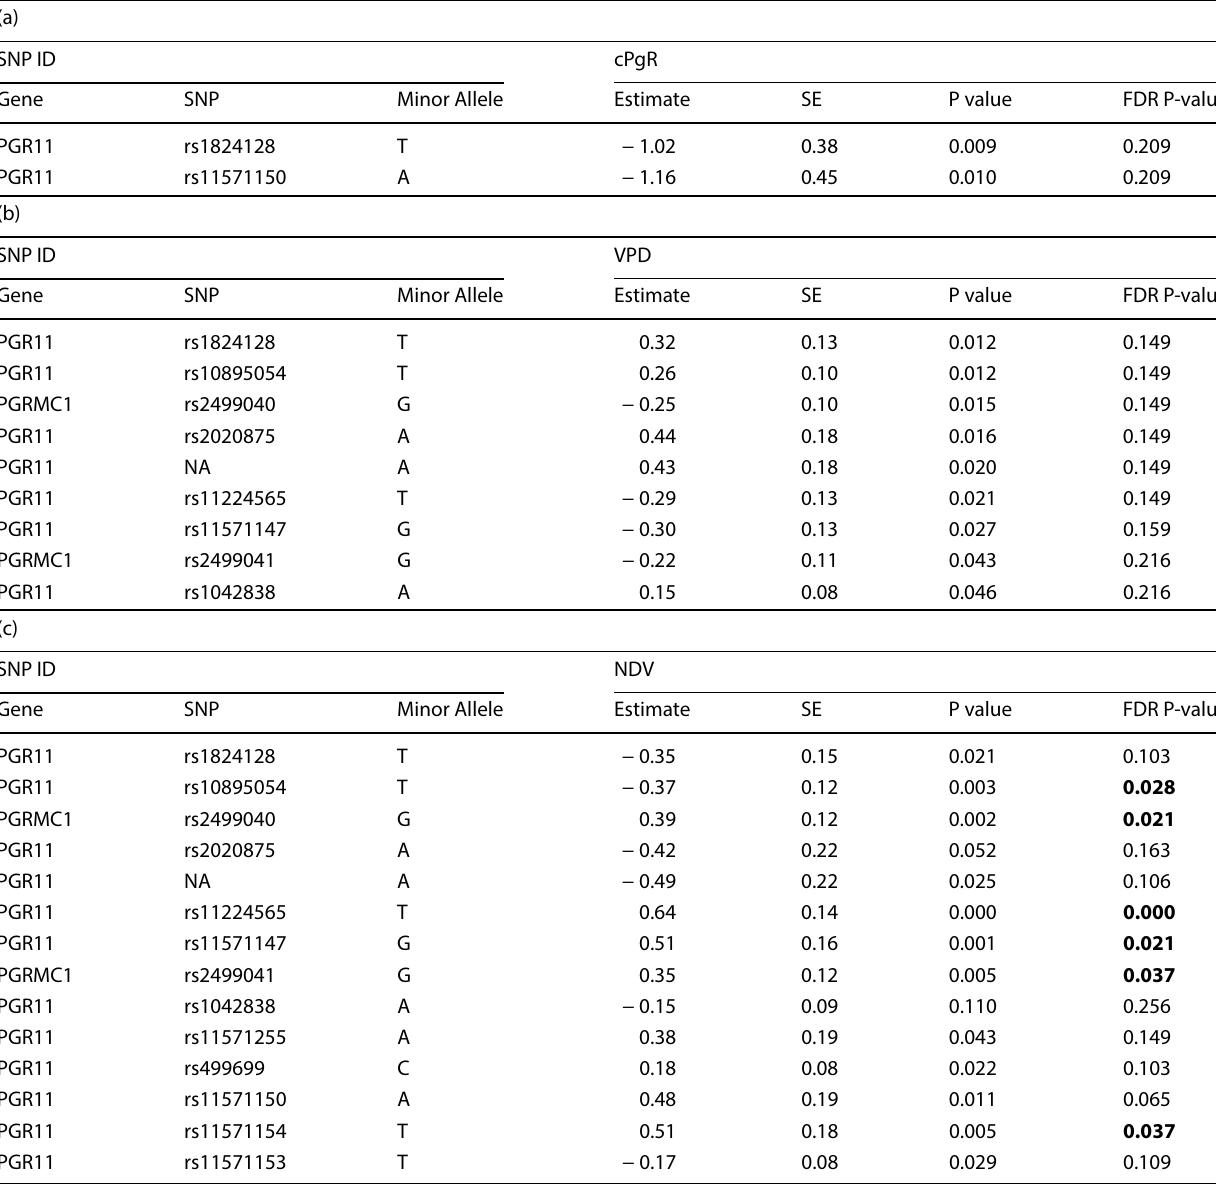
Table 2 Single nucleotide polymorphisms (SNPs) with significant univariate associations (without adjustment for covariates) among 42 SNPs: with genotype 1 frequency > = 3% and count > = 10) with (a) circulating progesterone (cPgR), (b) volumetric percent density (VPD) and (c) non-dense volume (NDV) from linear